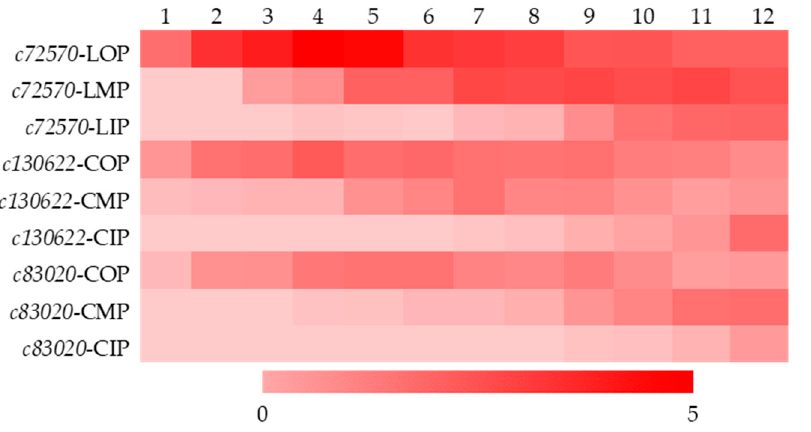
Figure 6. Heat map of gene expression patterns. 1–12: stage 1–12 (Figure 1); c72570 , c130622 , and c83020 were unigenes annotated as encoding 3GT, 3GT, and 3MAT based on transcriptome sequencing; LOP, LMP, and LIP stood for outer petals, middle petals, and inner petals of variety ‘Jiaoyan zhuanhong’; COP, CMP, and CIP stood for outer petals, middle petals, and inner petals of variety ‘Jiaoyan yanghong’. The darker the color of the square within the heat map, the higher the expression level.